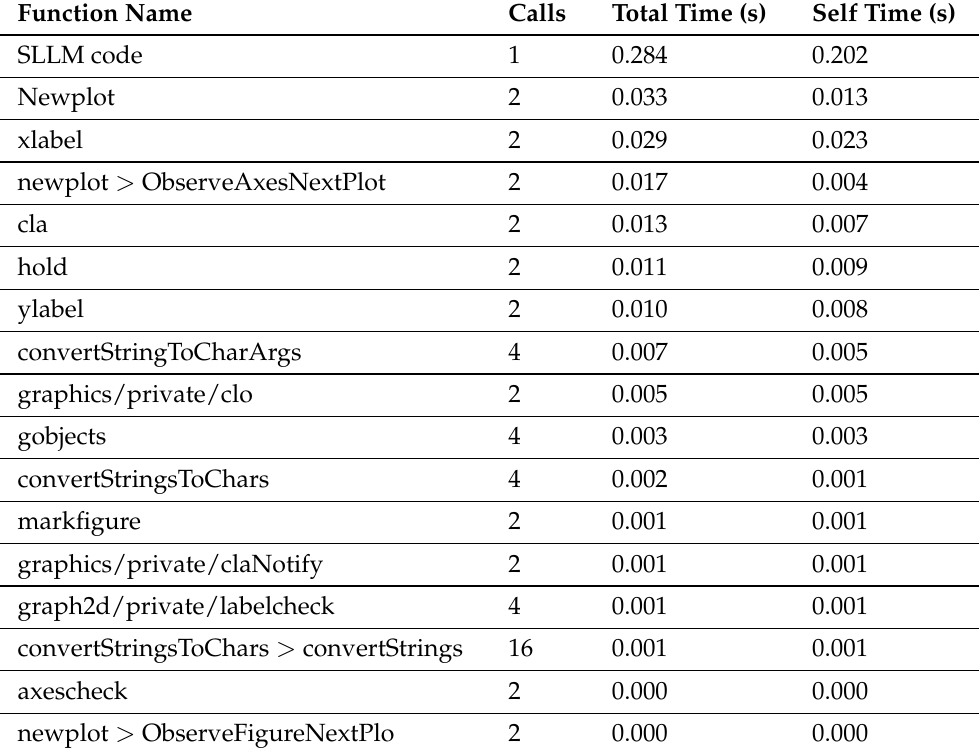
Table 2. Machine time to execute the Matlab code on intel core i7.